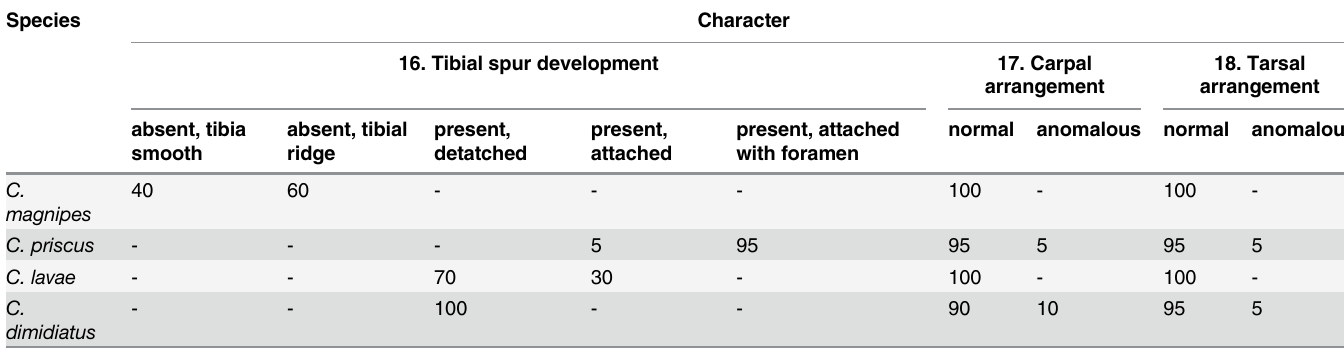
Frequencies calculated by considering right and left sides separately. Ten specimens of each species were